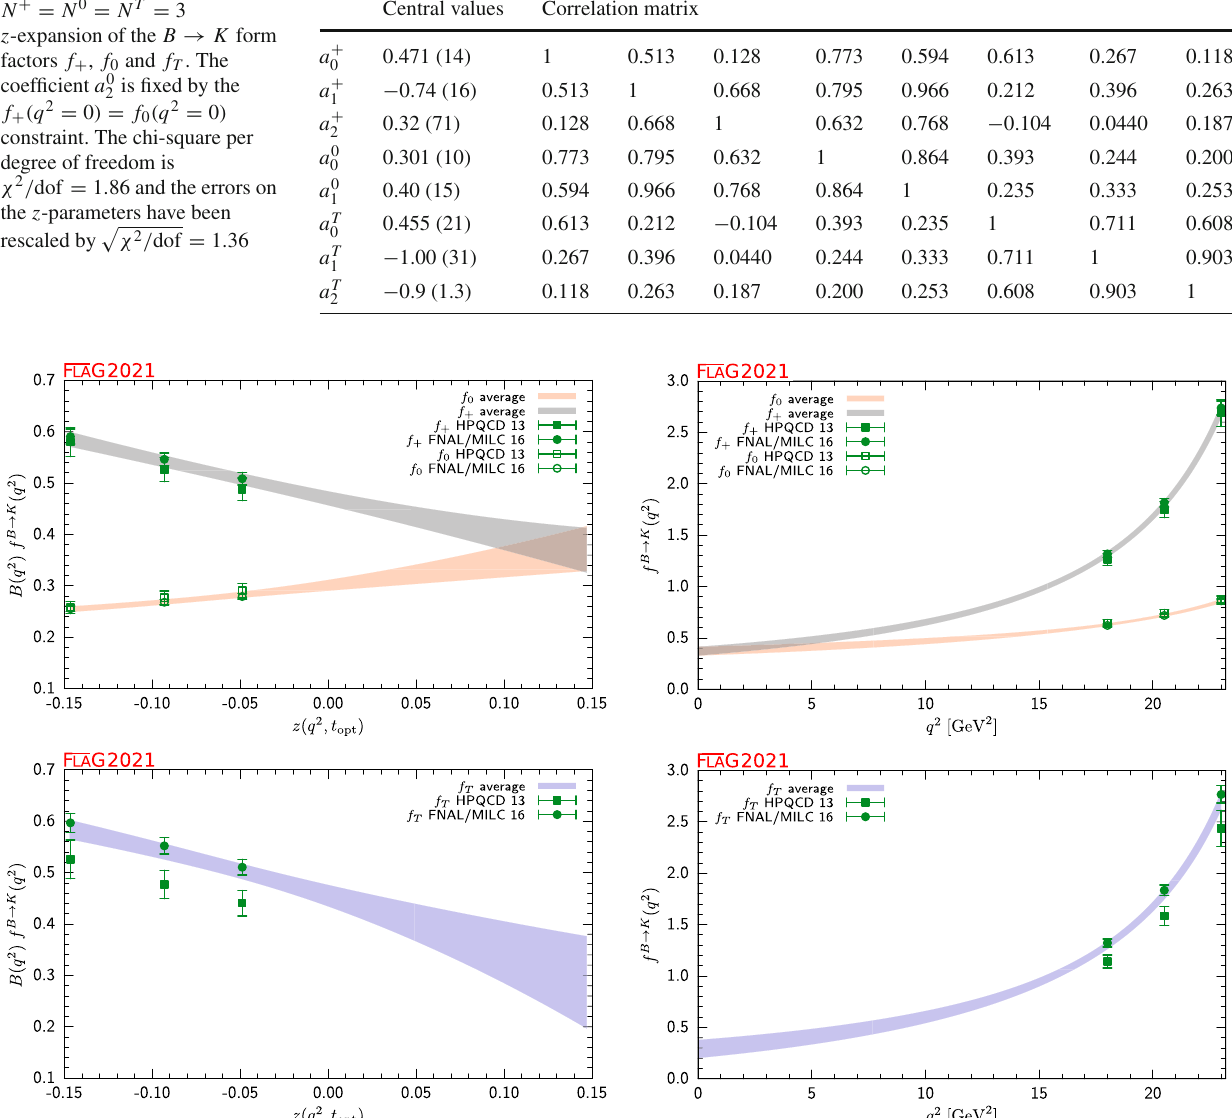
Fig. 33 The B → K form factors f + ( q 2 ) , f 0 ( q 2 ) and f T ( q 2 ) plotted versus z (left panels) and q 2 (right panels). In the plots as a function of z , we remove the Blaschke factors. See text for a discussion of the data sets. The grey, salmon and blue bands display our preferred N + = N 0 = N T =